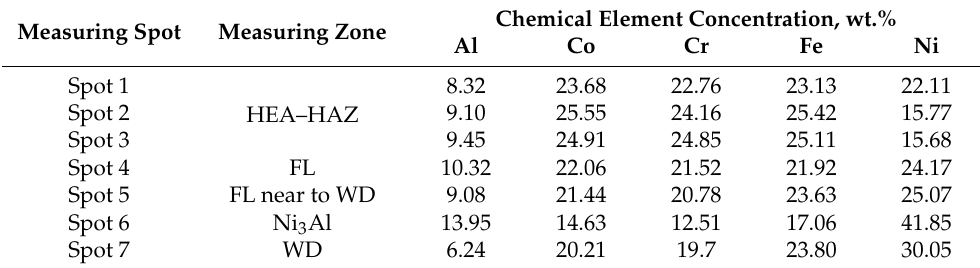
In the weld area, at about a 12 µm distance from the fusion line, the percentage of Ni was found to be in the range of 25 wt.% and 41.85 wt.%, which is lower than the nominal concentration of 56.4 wt.% from the filler metal. This decrease was caused mainly by the diffusion of Ni and the formation of Ni 3 Al compound (Table 2, Spot 6) that are characterized by high hardness. The Ni 3 Al intermetallic phase is usually caused by high-temperature diffusion processes and the reaction between AlNi and Ni [60]. The (Ni, Al)-rich phases were also visible on the distribution maps of chemical elements devel- oped on the fusion line between HEA and weld metal (Figure 6). It was noticed how the Ni- and Al-rich intermetallic phases began to form and increase, as dendrites, from the FL to the weld metal.